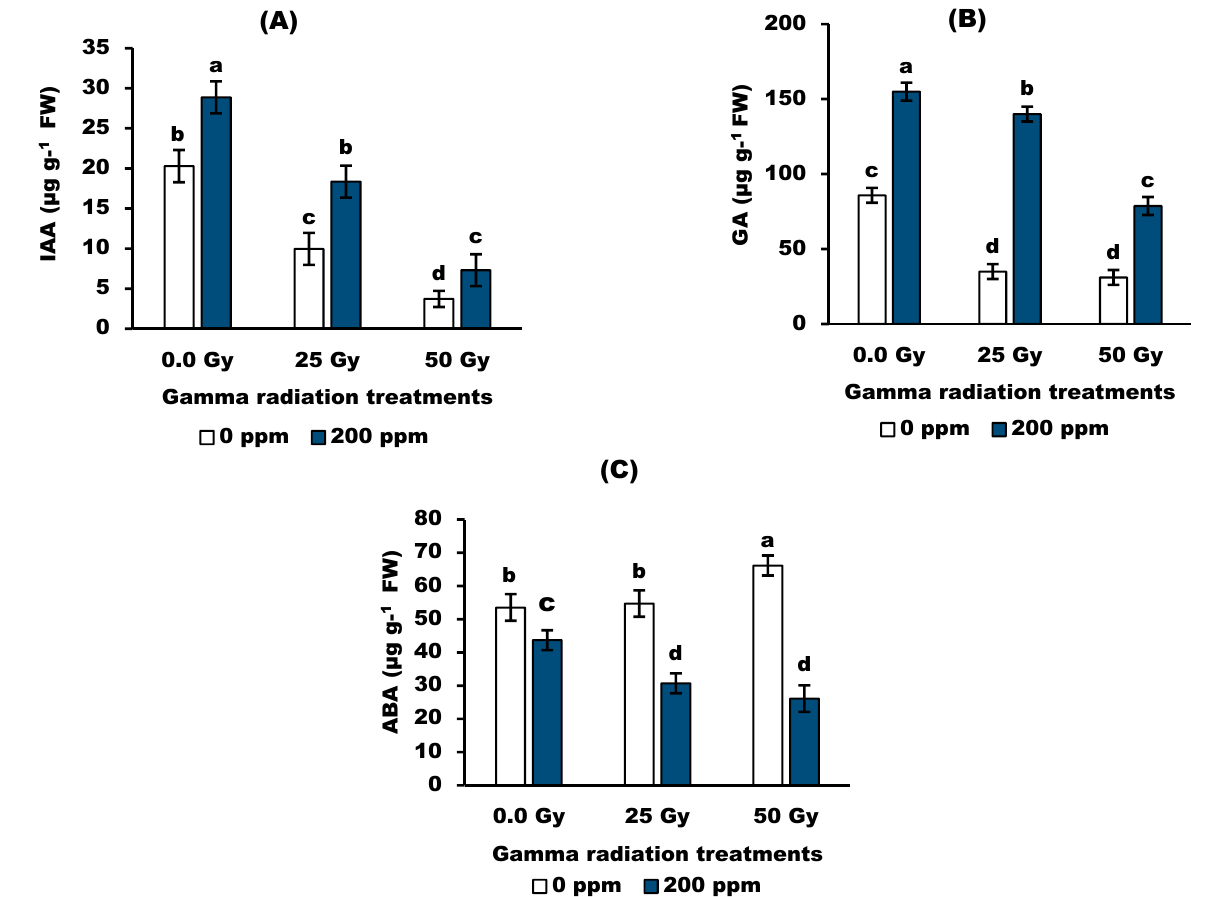
Figure 2. Effect of stigmasterol treatments on endogenous phytohormones; ( A ) IAA, ( B ) GA, and ( C ) ABA of wheat plants grown from grain irradiated with gamma rays. The different letters (a–d) show statistical significance at p < 0.05; vertical bars indicate ±SD.